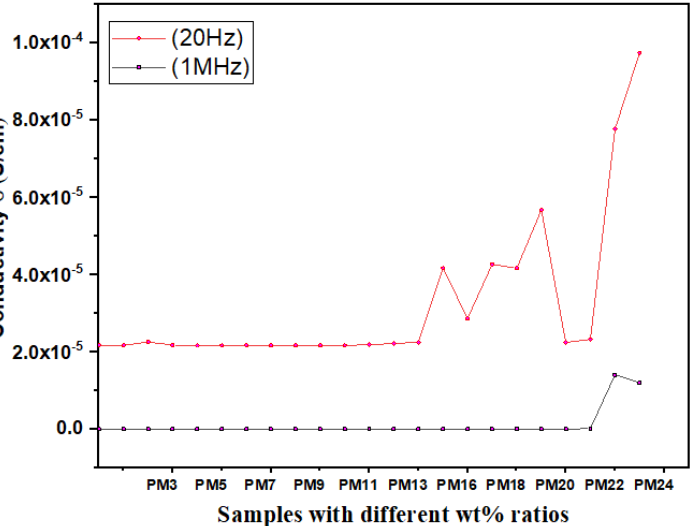
Figure 6. Conductivity “ σ ” dependence on different polymer nano composite films at frequencies 20 Hz and 1 MHz.